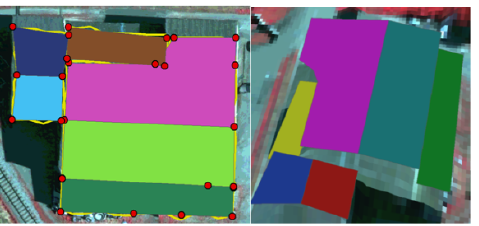
Fig. 10. Intersection points (red) of the roof outlines and reconstructed roof (Left: top view, right: 3D view).